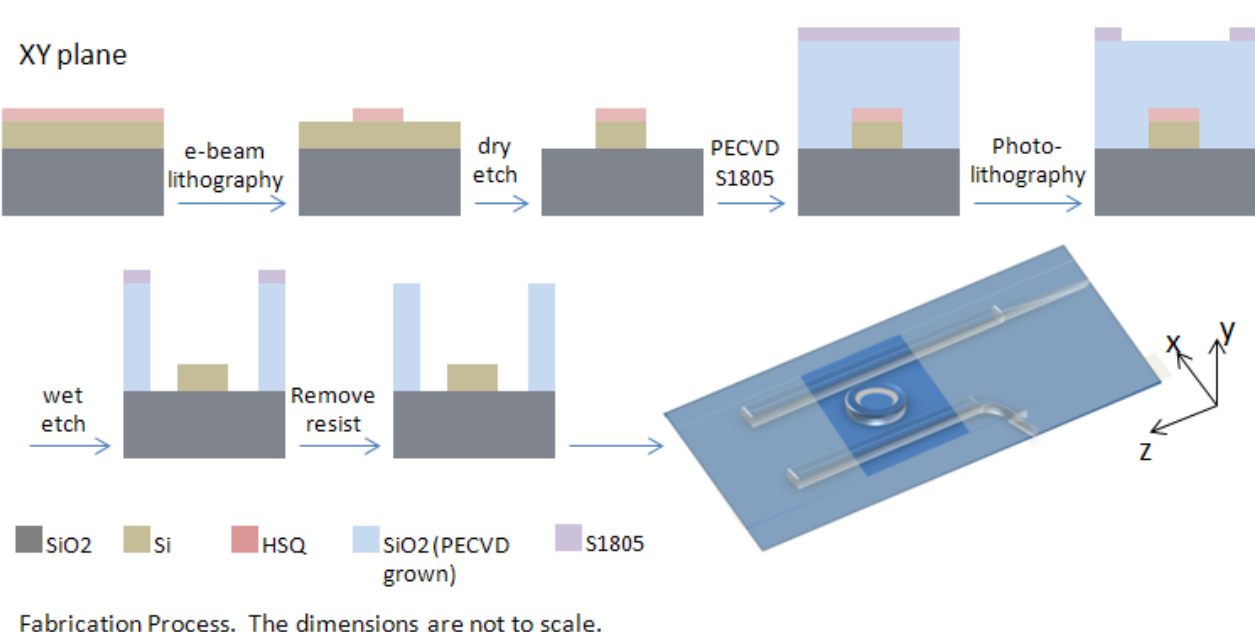
Figure 6. Fabrication process steps.